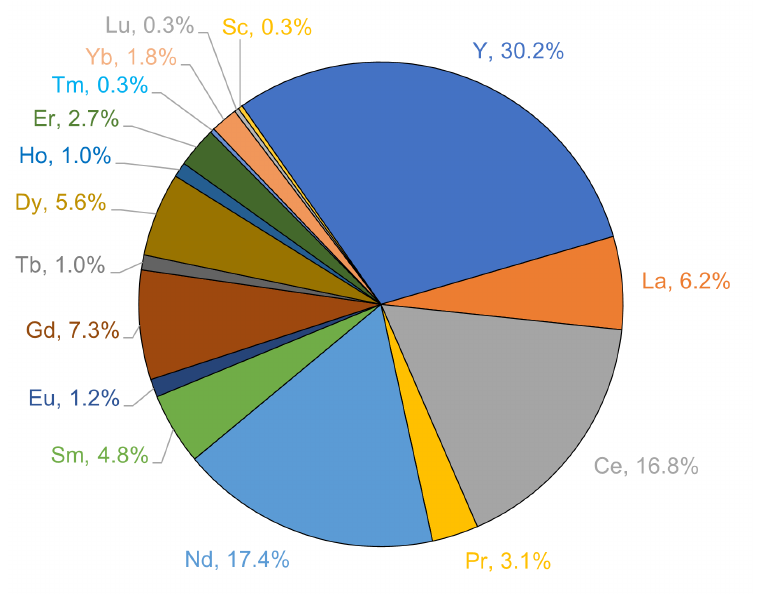
Figure 1. Composition of pre-concentrate material generated at Bismarck, WV, AMD treatment